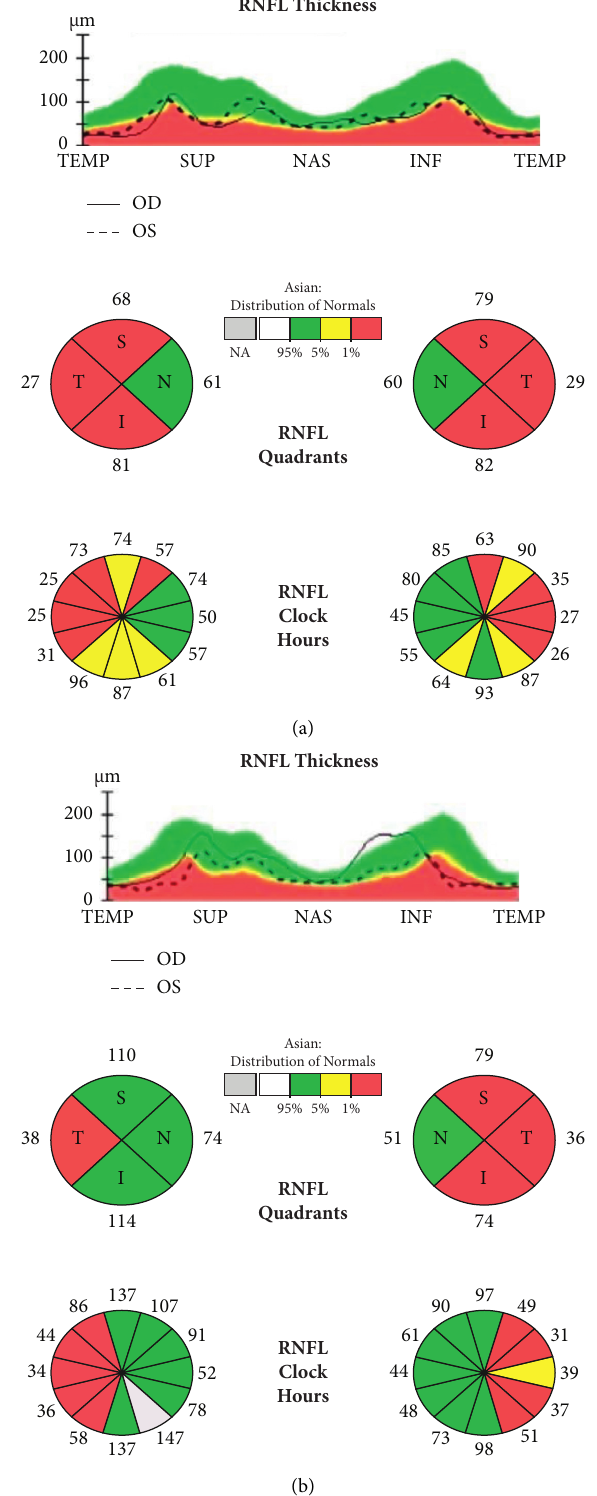
Figure 2: Optical coherence tomography shows retinal nerve fiber layer of optic nerve heads. (a) Mother: bilateral severely affected retinal nerve fiber layer. (b) Son: severely affected superior, inferior, and temporal quadrants of the left eye and severely affected temporal quadrant of the right